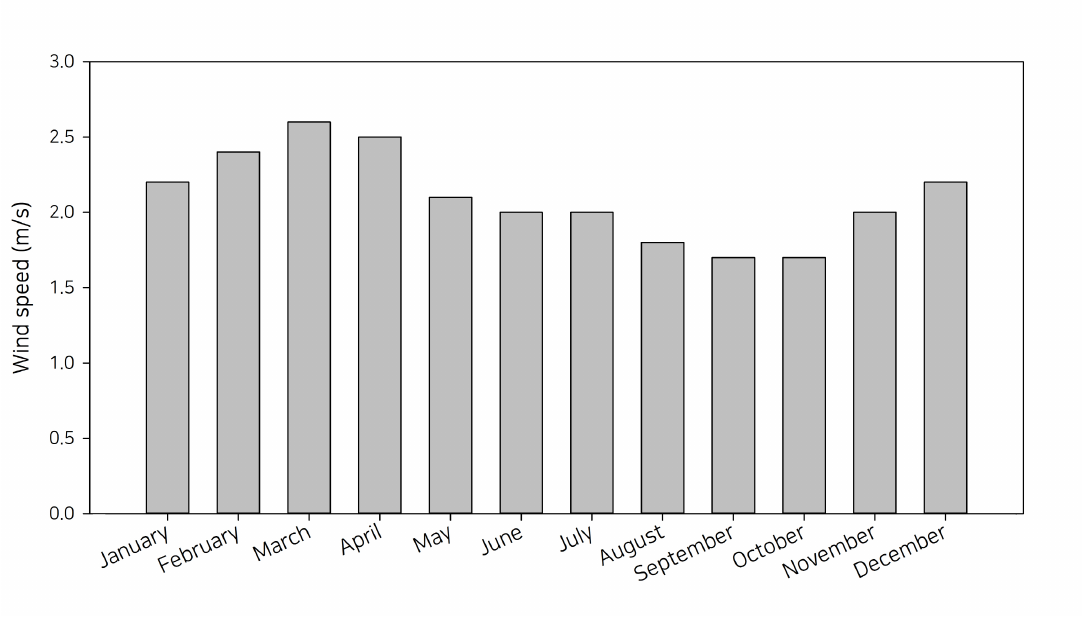
Figure 2. Average wind speeds at